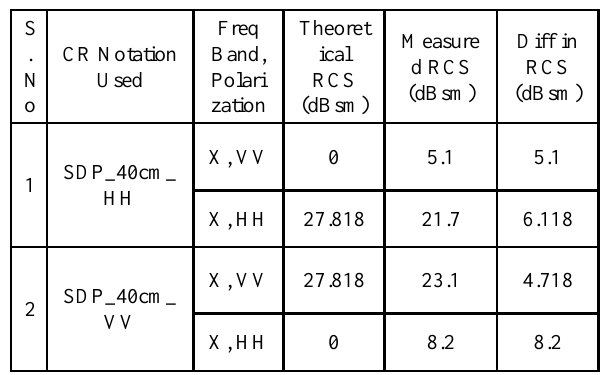
Table 3: Summary of RCS measurements for